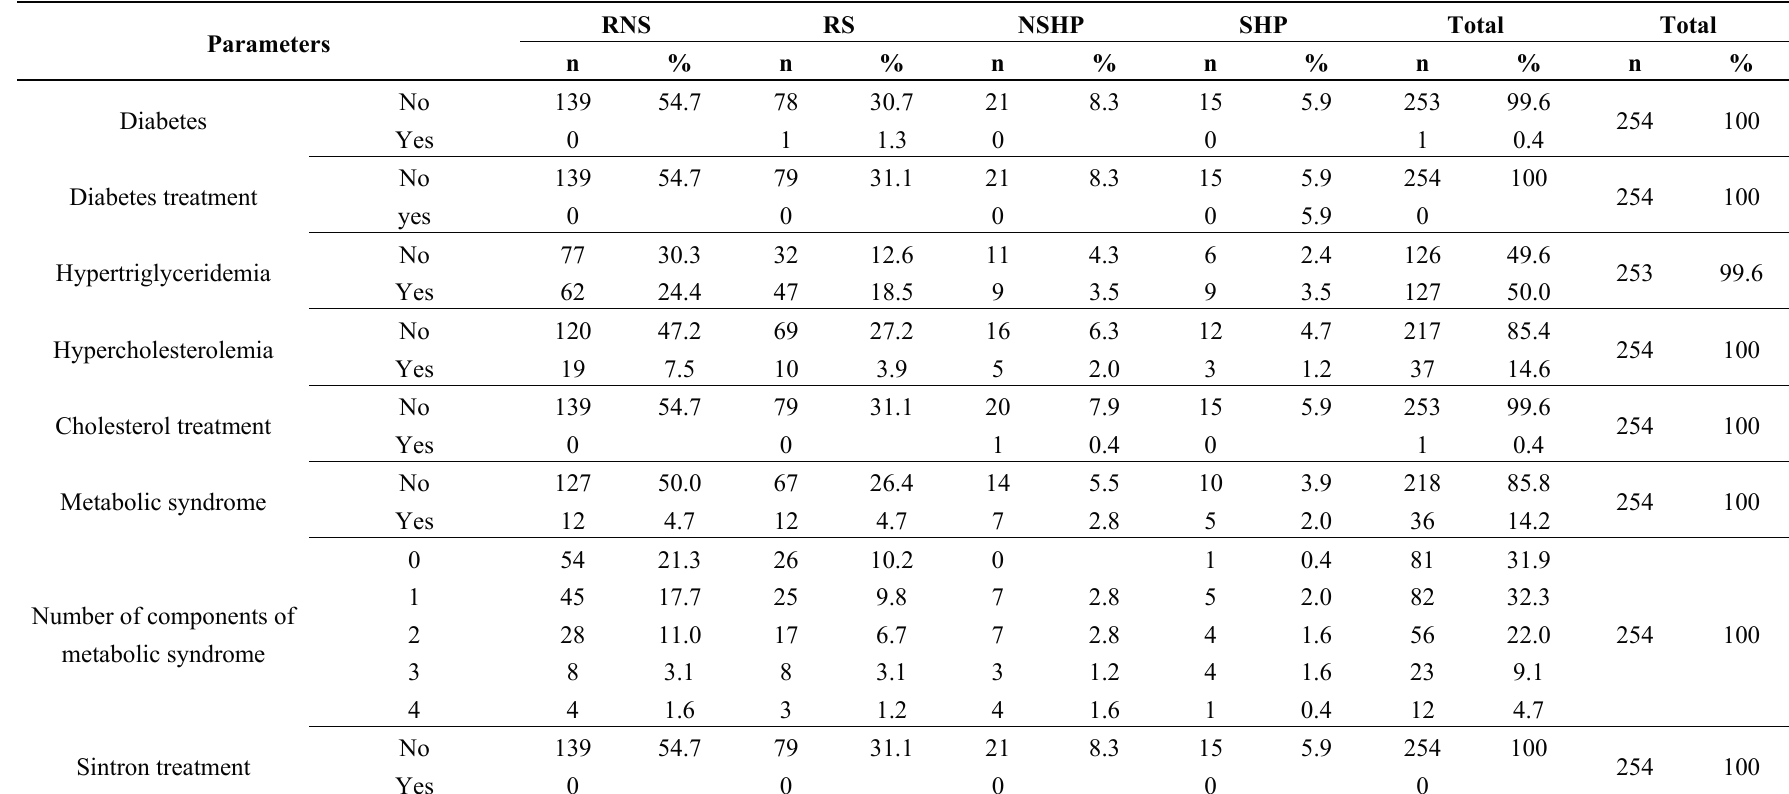
Table 2. Prevalence of diseases in the study